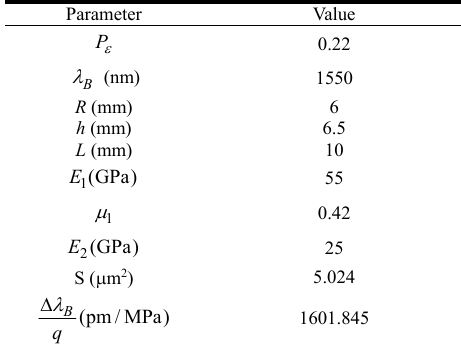
Table 2 Parameters describing the various parameters of the sensor as employed in (3) for the relationship between the wavelength change and external